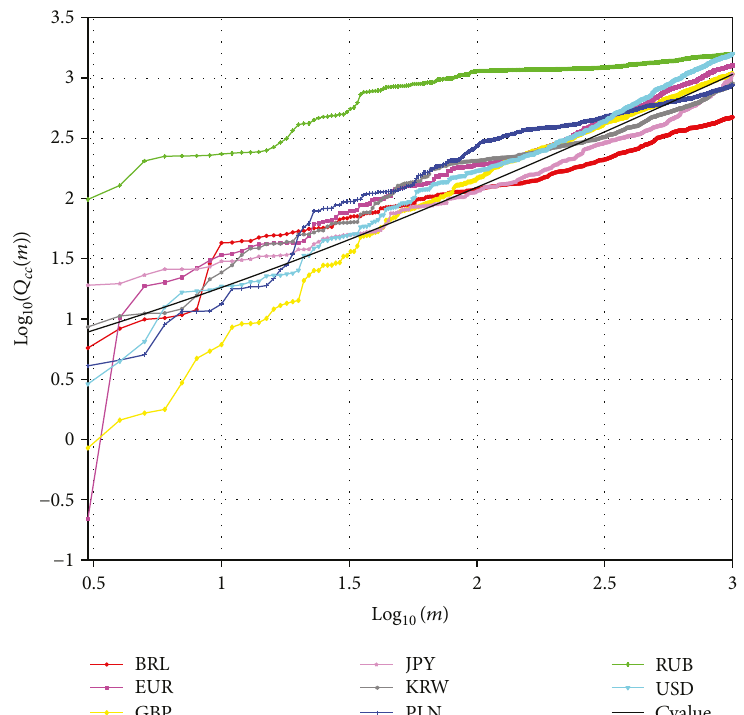
Figure 4: The cross-correlation statistics between price and